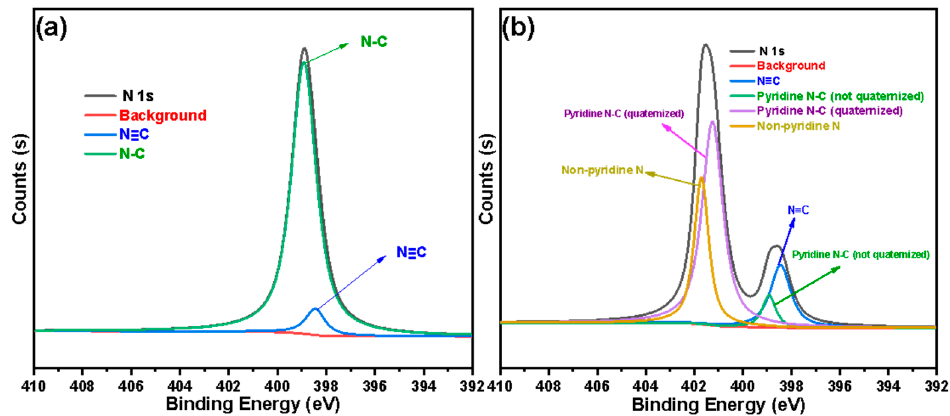
Figure 8. The deconvolution of N 1s spectra: SG-VTS-VP ( a ), SG-VTS-VPQ ( b ).